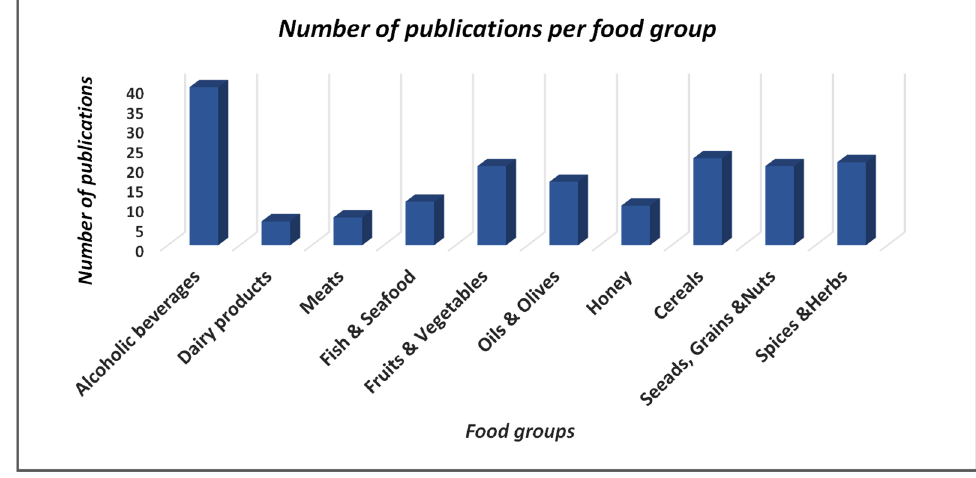
Figure 5. Diagrammatic representation of the number of publications with regards to the type of